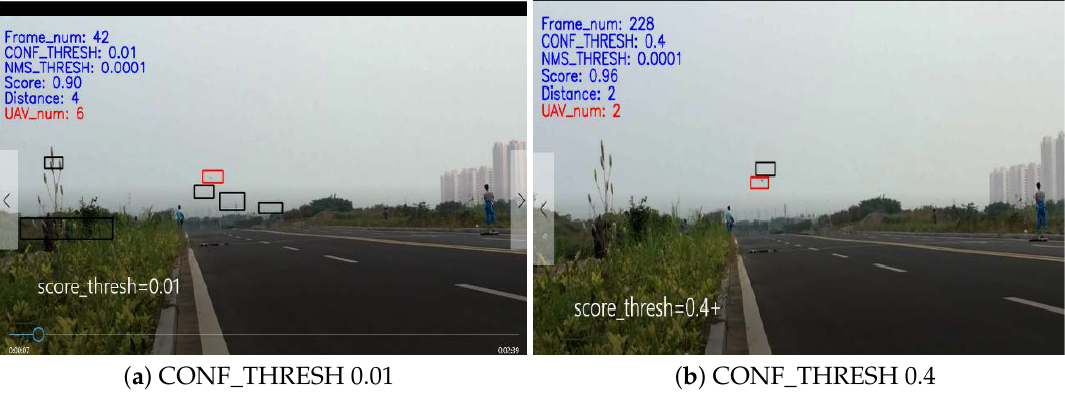
Figure 10. Comparison of different CONF_THRESH